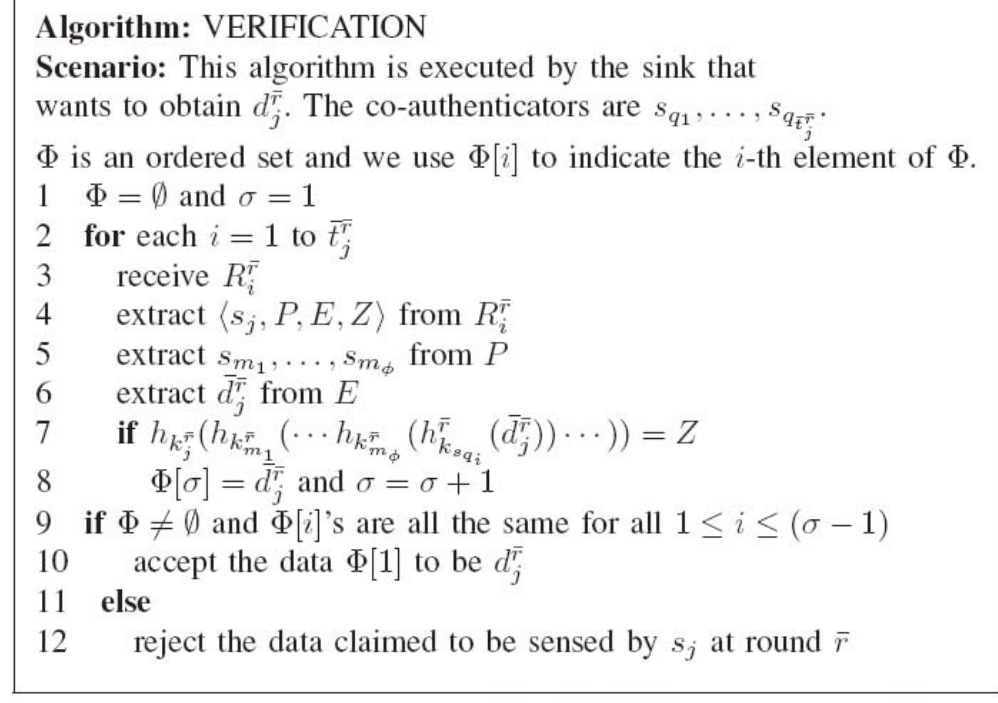
Figure 7. The algorithm of verification